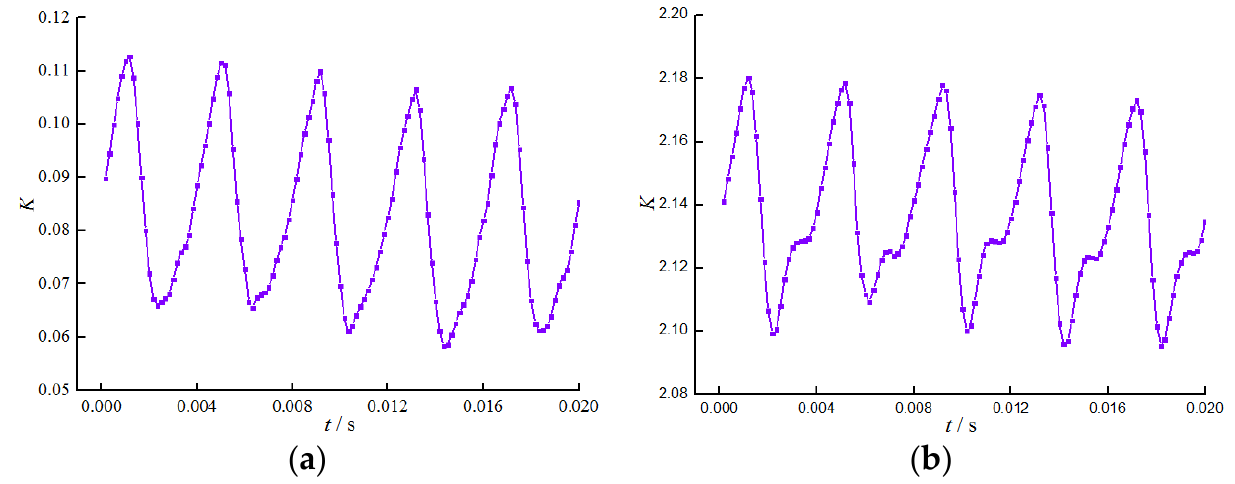
Figure 17. Time-domain results of the coupled hydraulic forces. ( a ) Impeller. ( b ) Housing.